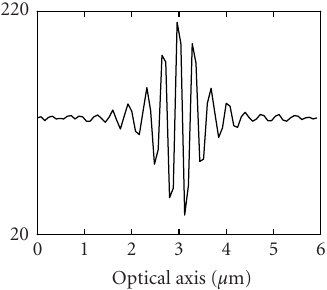
Figure 1: Typical intensity along the optical